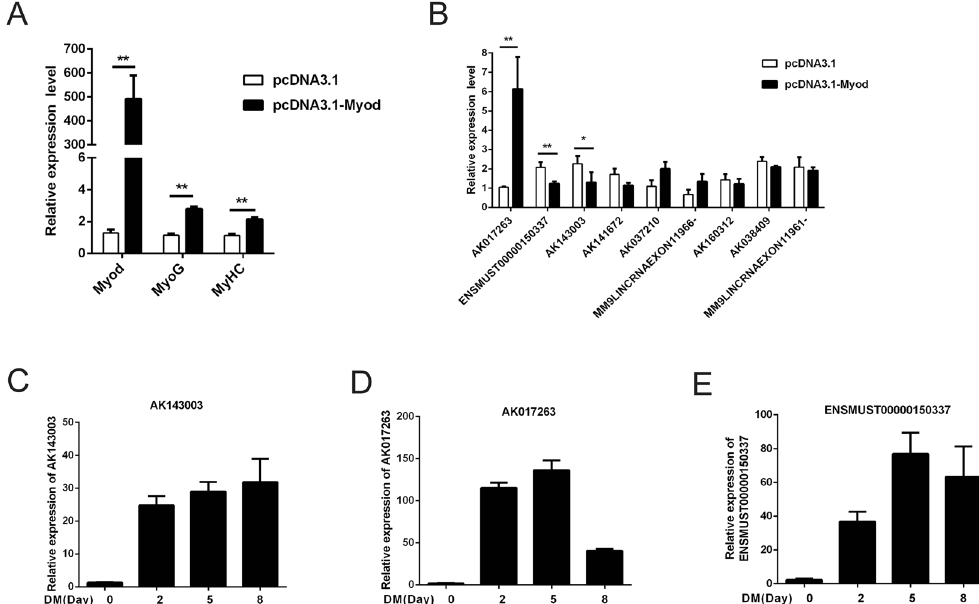
Figure 2. Expression profile of candidate lncRNAs. ( A ) Overexpression of MyoD caused the increased mRNA level of MyoG and MyHC gene. ( B ) The differential expression of lncRNAs from A. ( C – E ) The expression